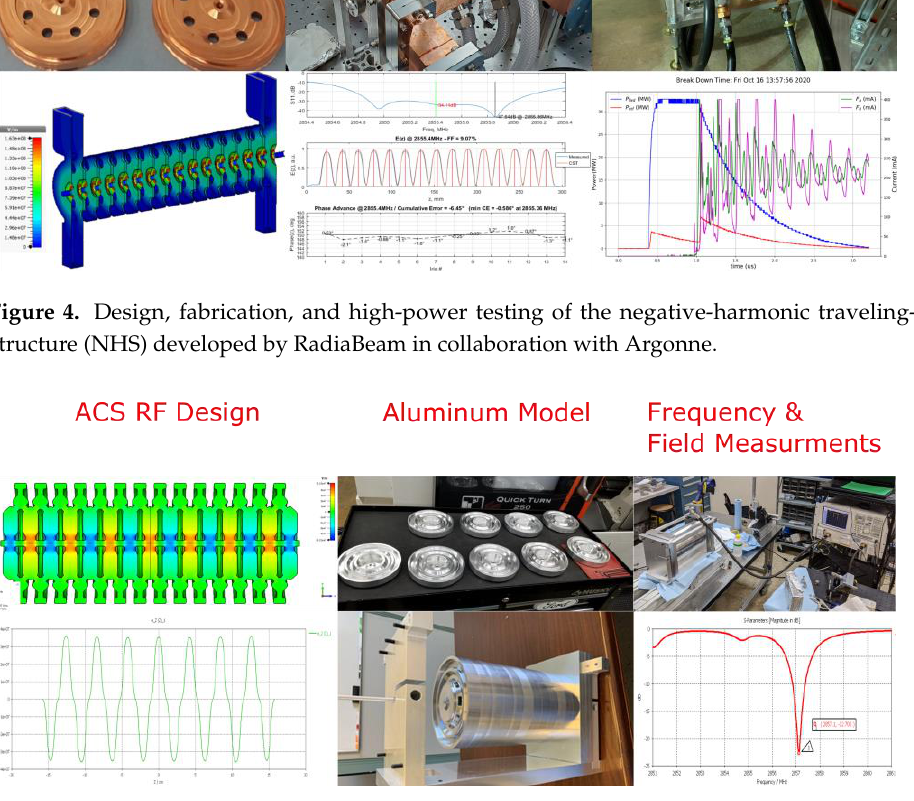
Figure 4. Design, fabrication, and high-power testing of the negative-harmonic traveling-wave structure (NHS) developed by RadiaBeam in collaboration with Argonne.